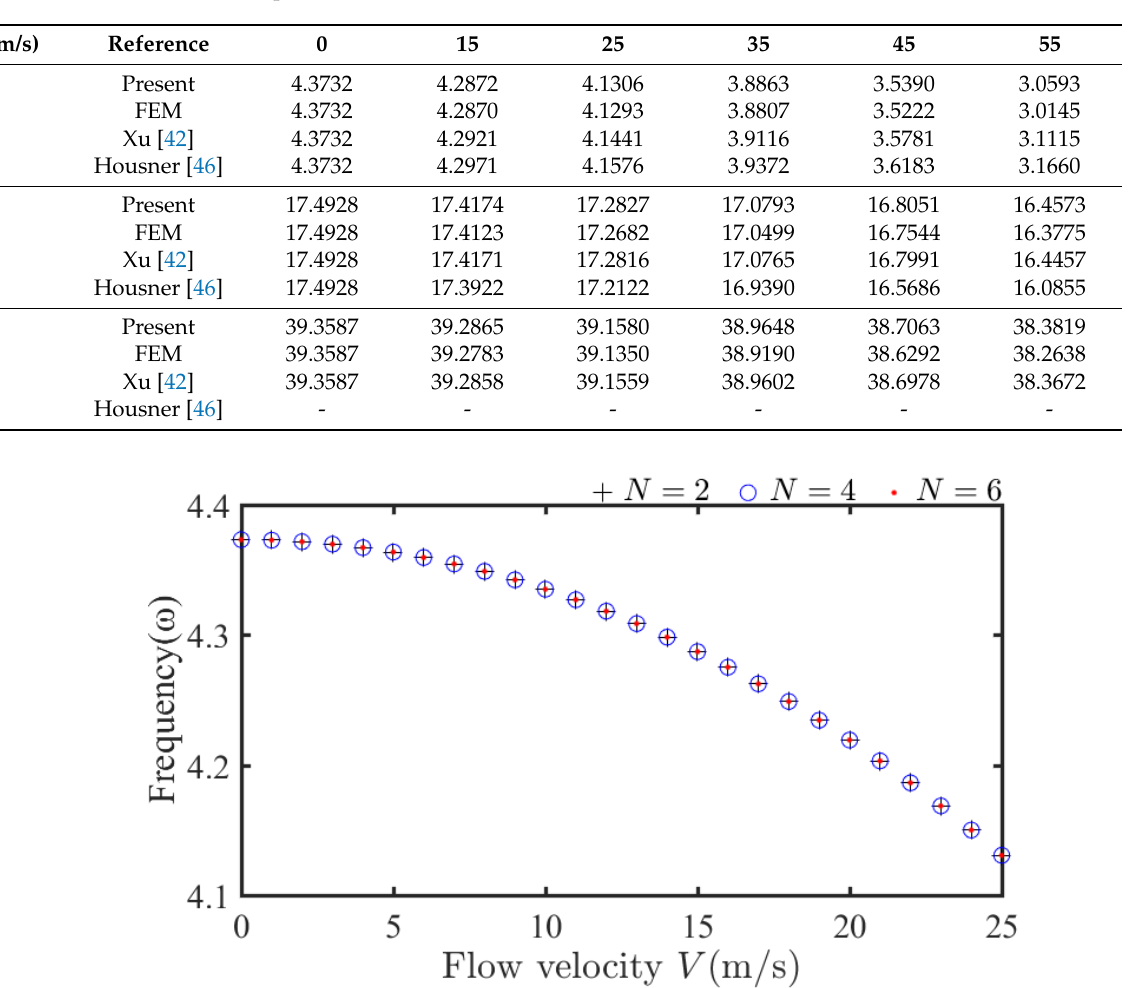
Table 3. Comparisons between the FEM results and theoretical values.